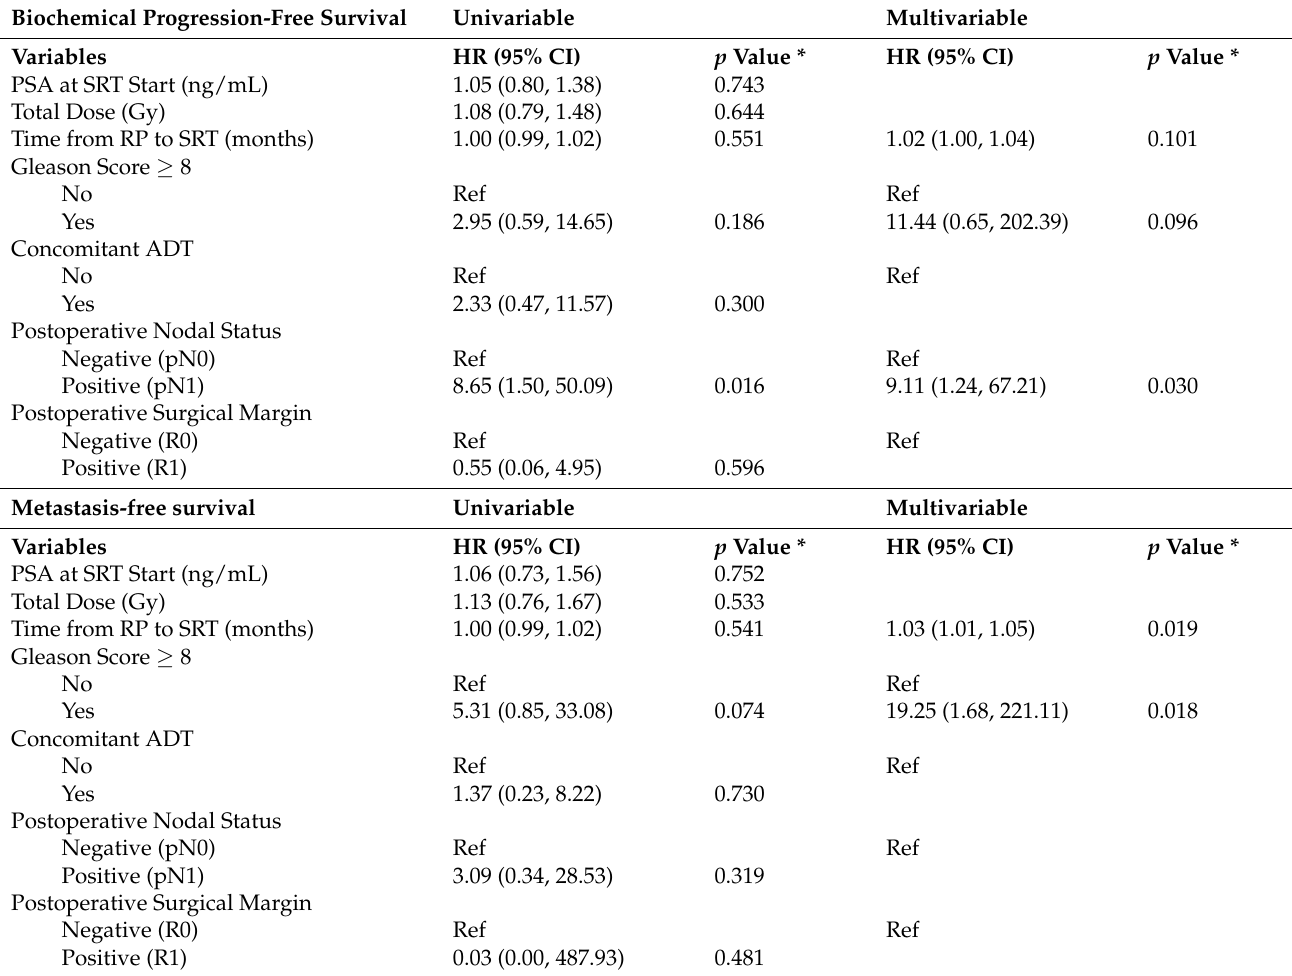
Table 3. Uni- and multivariable Cox proportional hazards model